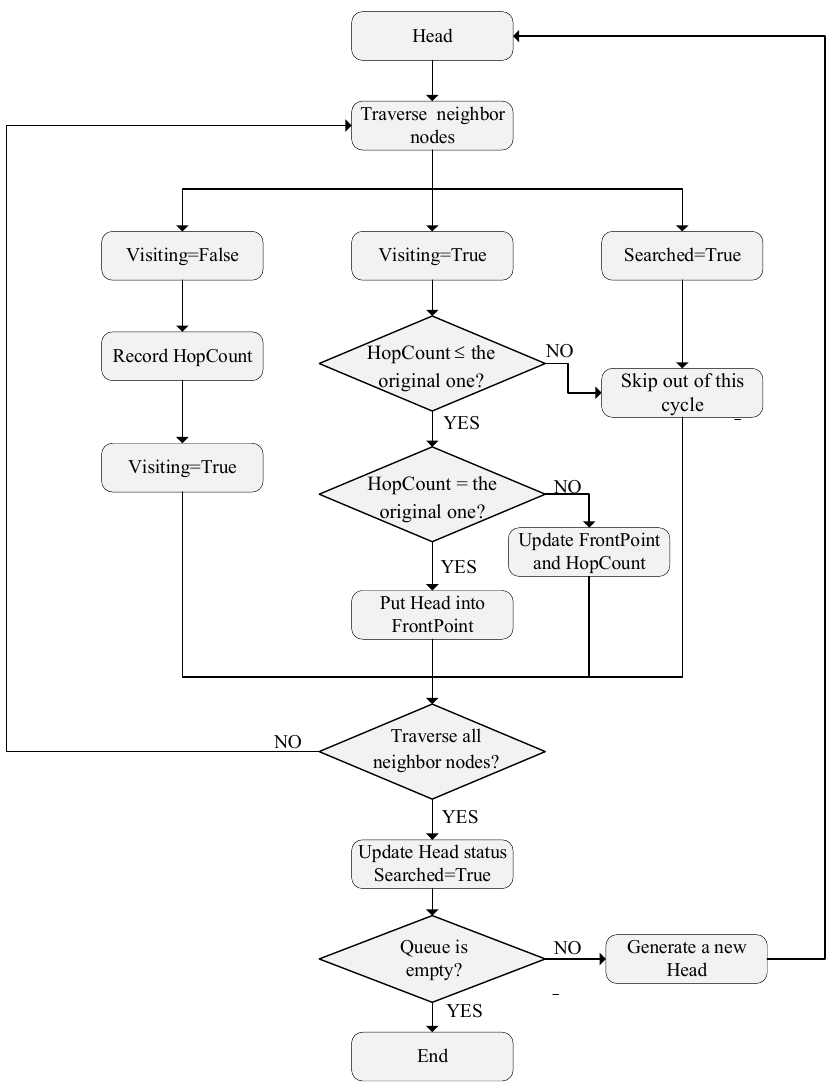
Figure 3. Flow chart of the improved breadth- fi rst search.